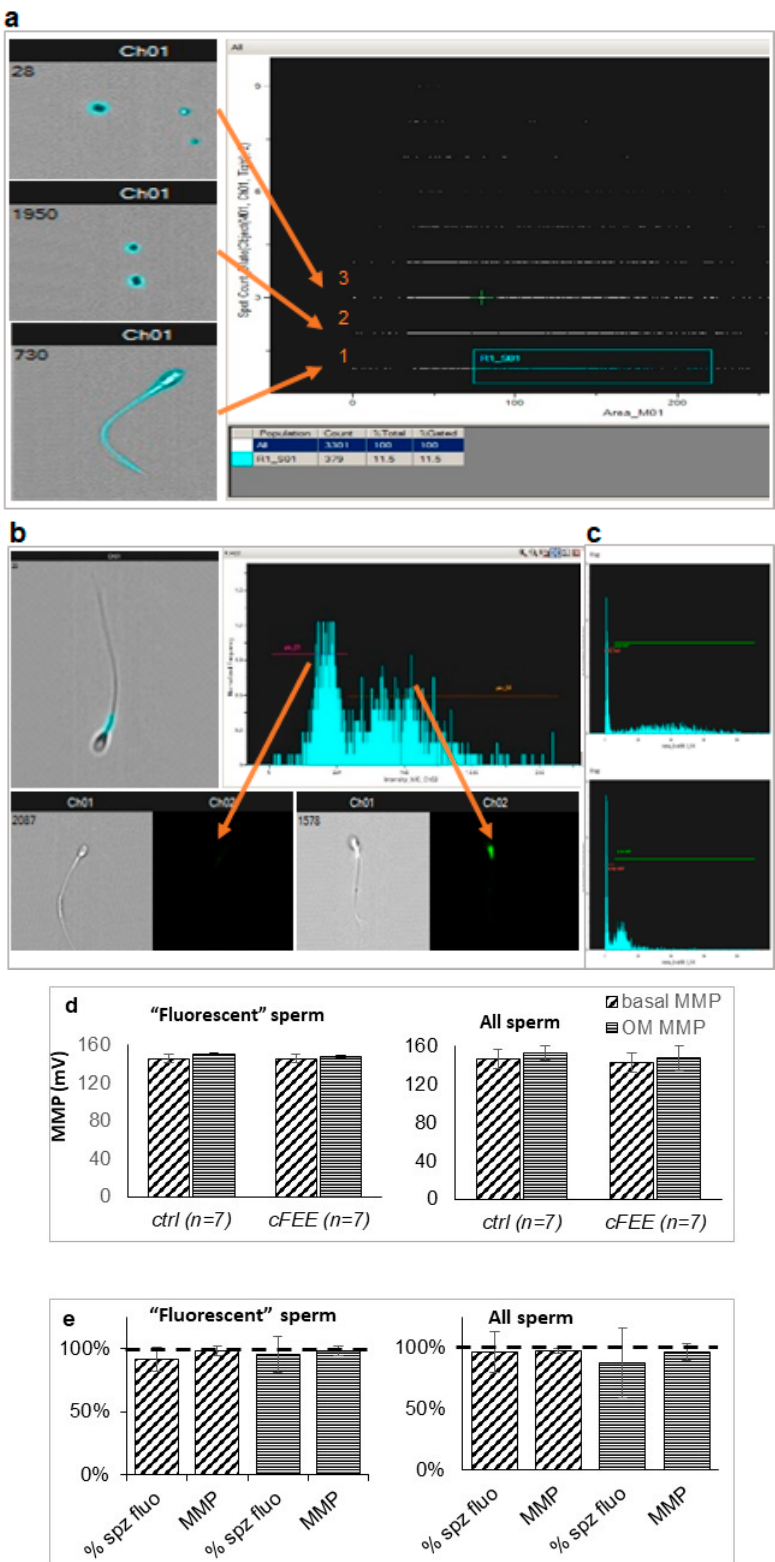
Figure 5. Flow cytometry coupled with microscopy confirmed the presence of sperm unstained by potentiometric fluo- rescence probes as well as the lack of impact on MMP of cFEE. ( a ) Scheme of the selection of relevant objects (arrows, 1: spermatozoa entirely fluorescent, 2 and 3: beads and debris) based on bright field images, using both the number per field and their size. ( b ) Non fluorescent objects were morphologically normal spermatozoa; fluorescent signal was localized in the middle piece of sperm as expected from a mitochondrial signal; the repartition of the fluorescence intensity allows for defining a population with very low fluorescence signal in a narrow “negative peak” (left arrow) and the rest of the pop ‐ ulation in a broad “positive peak” (right arrow). ( c ) The positive and negative peaks previously defined in the basal state were transferred to the histogram obtained with oligomycin or antimycin + CCCP inhibition, allowing for the evaluation of the proportion of fluorescent sperm (# sperm in positive peak/total # sperm analyzed) and MMP (according to the Nernst law taking as zero signals the fluorescence value in antimycin + CCCP). ( d ) cFEE had no impact on the MMP in basal conditions (obliquely shaded bars) or after oligomycin inhibition (horizontally hatched bars), whether analyzed only in the positive peak (“fluorescent” sperm) or in the whole sperm population (All sperm); MMP expressed in mV using the Nernst equation. ( e ) cFEE had no impact on the proportion of sperm in the positive peak (% fluorescent sperm) nor on the MMP in basal conditions (obliquely shaded bars) or after oligomycin inhibition (horizontally hatched bars) whether ana ‐ lyzed only in the positive peak (“fluorescent” sperm) or in the whole sperm population (All sperm); MMP and proportion of sperm in the positive peak expressed as % of the condition without cFEE in the 3 ‐ h incubation prior to analysis. 3. Discussion We have previously shown in mice that the cQDE peptide, equivalent to cFEE in hu ‐ man, increases the fertilization rate in the intact ‐ cumulus assay. The cFEE peptide also increases the fertilization index using zona ‐ free human oocytes. In fact, it increases sperm movement parameters and the percentage of human hyperactivated sperm by 30%, which should increase IVF fertilization rates. Since the sperm is moving faster, one can expect that it has an improved ATP production, which was not the case. Finally, the peptide had no deleterious effect on the nuclear quality: sperm DNA fragmentation was not modified after 24 h of incubation with the peptide, suggesting a good tolerance of the molecule by gametes. We first showed that cFEE binds to sperm regardless of its maturation status (non ‐ capacitated, capacitated, or acrosome reacted). Then, we sought to specify its location ac ‐ cording to the maturation of the sperm. Indeed, essential sperm proteins (such as IZUMO1